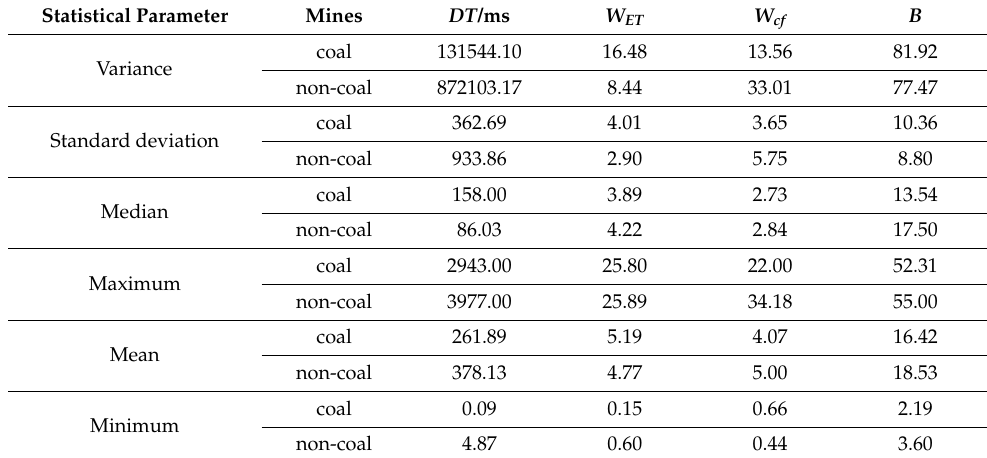
Table 2. Statistical parameters of the rockburst indices of coals and non-coal rocks.